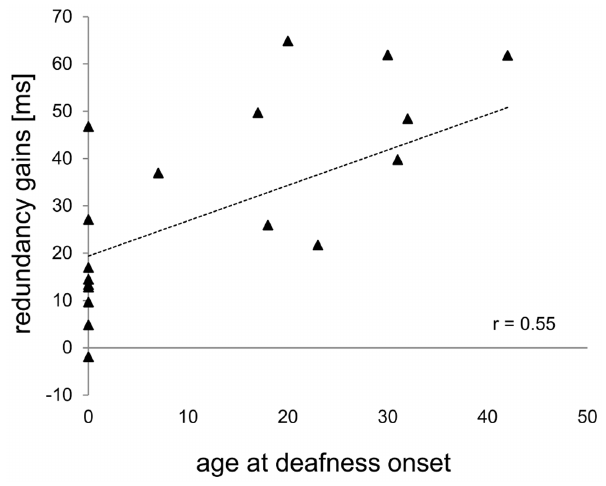
Figure 4. Correlation between redundancy gain and age at deafness onset. Redundancy gains (in ms) plotted as a function of age at deafness onset (in years).